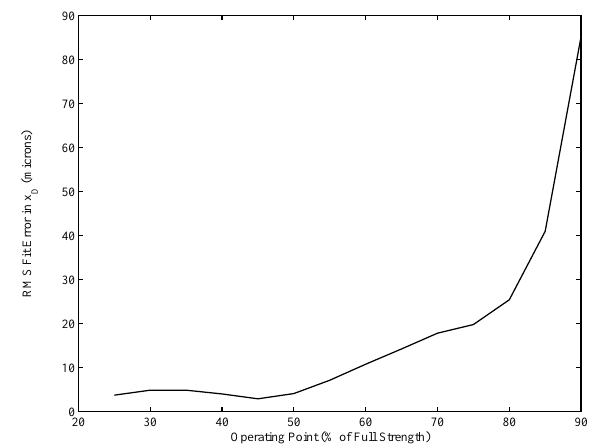
FIG. 9. rms fit error on x D when x D and (cid:2) x are fitted, but ¨ x is ignored, for the solid-core quad modeled in the text. The case shown is a symmetric five step scan in which the maximum excursion is 10% of the operating